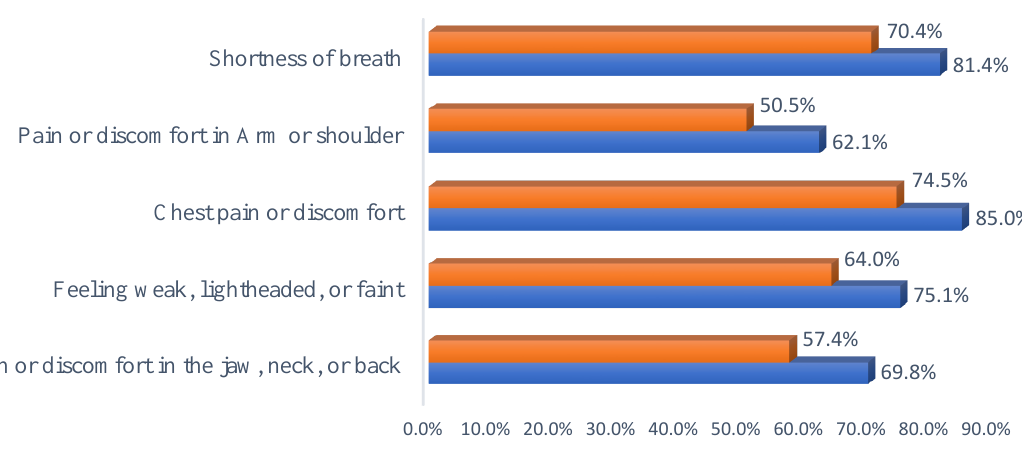
Figure 2. Percentage of participants who recognized each symptom of the Knowledge of CVDs warning signs.